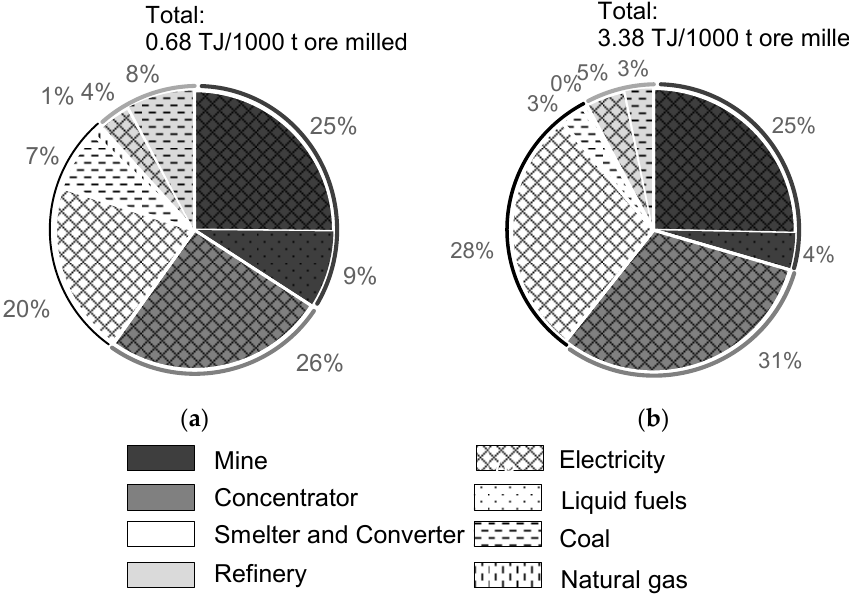
Figure 7. Average consumption of electricity, liquid fuels, coal and natural gas 2010 to 2015 for different processing stages ( a ); and corresponding CED fossil ( b ). Minor shares of other fuels are not depicted. Part ( a ) is based on data from Anglo Platinum [63–67,90].